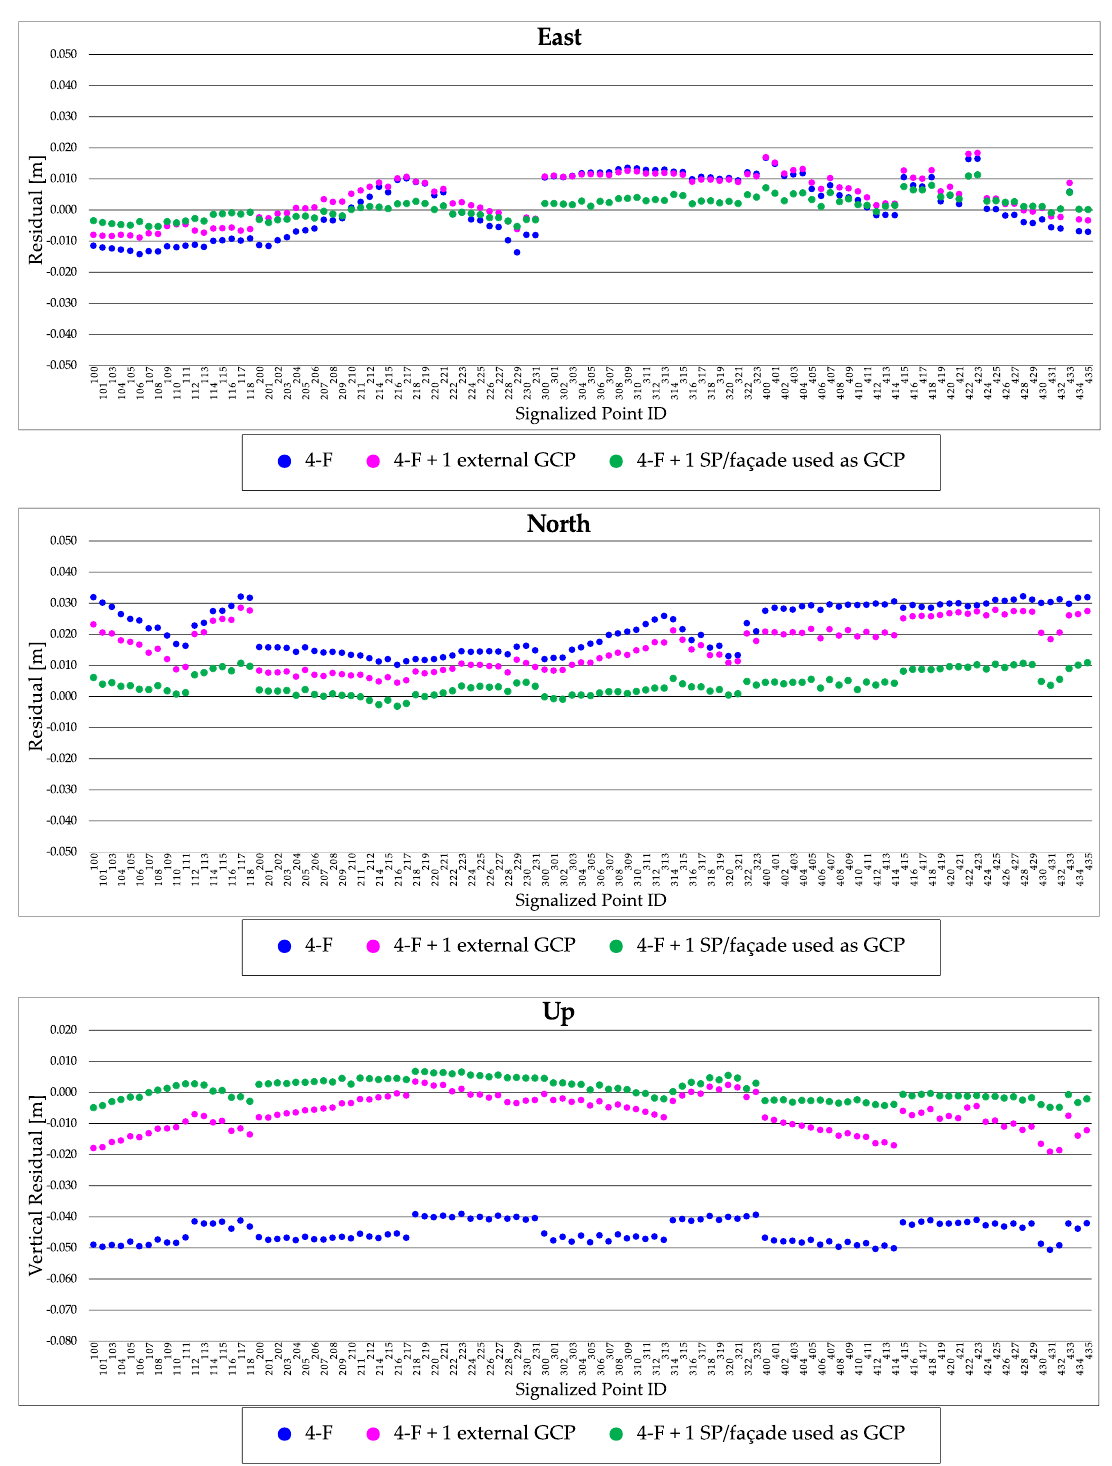
Figure A9. E, N, U residuals for different approaches of vertical offset removal – RTK